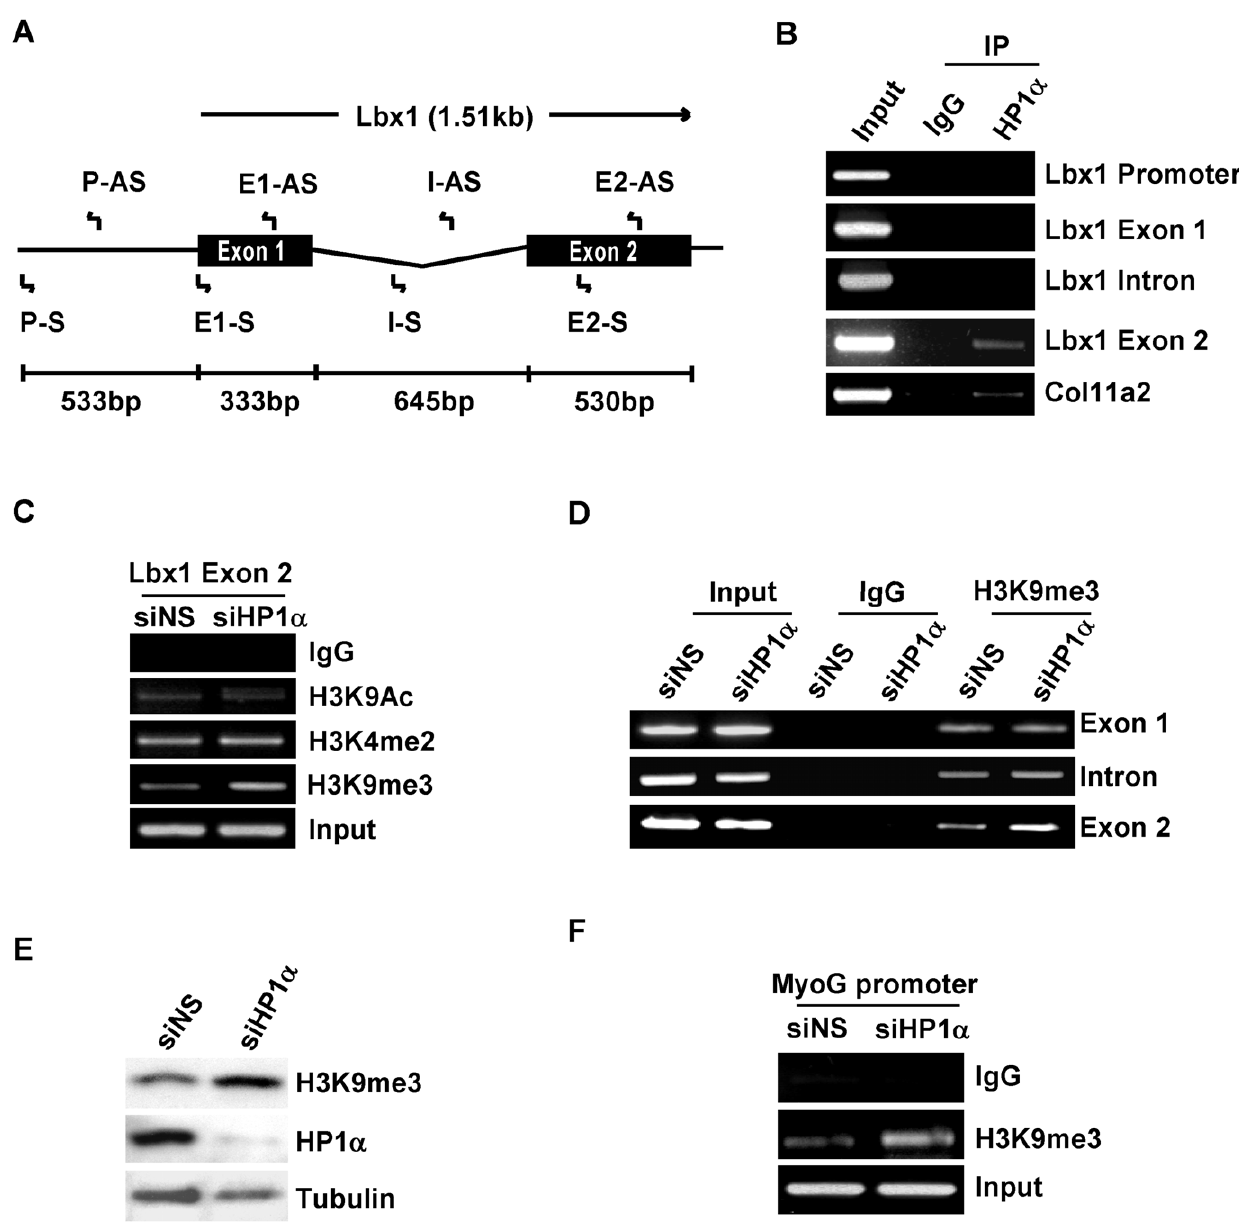
Figure 5. H3K9me3 levels on myogenic genes increased in C2C12 myoblasts after depleting HP1 a . A. Schematic diagram of the genomic structure of the mouse Lbx1 gene and locations of primers used for subsequent ChIP experiments. B. Protein-DNA complexes from cross-linked chromatin extracted from C2C12 myoblasts cultured in GM were immunoprecipitated with HP1 a or mouse IgG. Bound DNA was amplified using the indicated PCR primers. C, D, C2C12 myoblasts were transfected with indicated siRNA, 48 hours after transfection, cross-linked chromatin was extracted and immunoprecipitated with indicted antibodies. Lbx1 exon 2 (C) or Lbx1 genomic sequences including exon 1, intron and exon 2 (D) were amplified. E. C2C12 myoblasts were transfected with the indicated siRNA, 48 hours after transfection total cell lysates were subjected to Western blotting with the indicated antibodies. F. C2C12 myoblasts were transfected with indicated siRNA, 48 hours after transfection cross-linked chromatin was extracted and immunoprecipitated with anti-H3K9me3 antibody. Precipitated DNA was used for PCR with primers spanning the MEF2-binding site on the myogenin gene promoter.